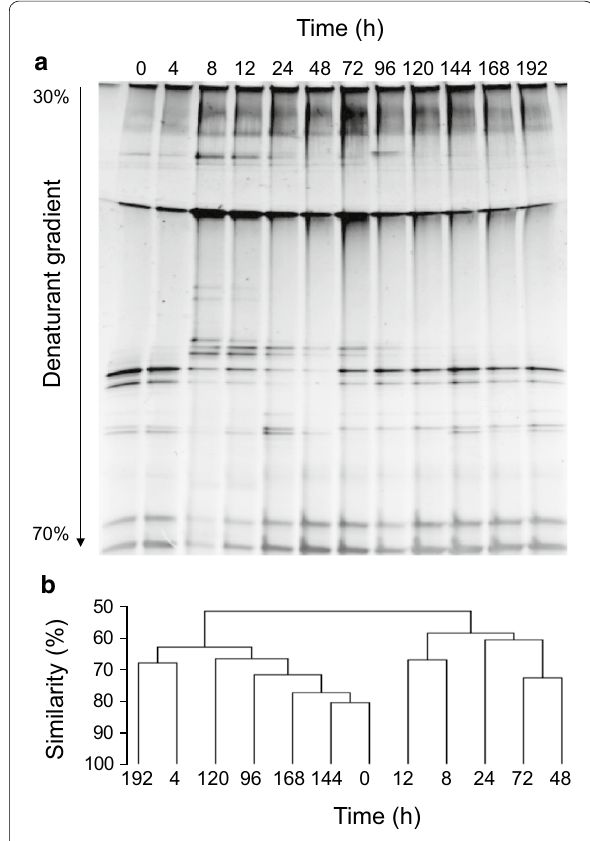
Fig. 4 Bacterial population and pH dynamics during NMP degradation. DGGE profile of bacterial 16S rRNA gene amplicons ( a ). UPGMA clustering of DGGE analysis (scale represents similarity from 50 to 100% according to the Jaccard coefficient) ( b )